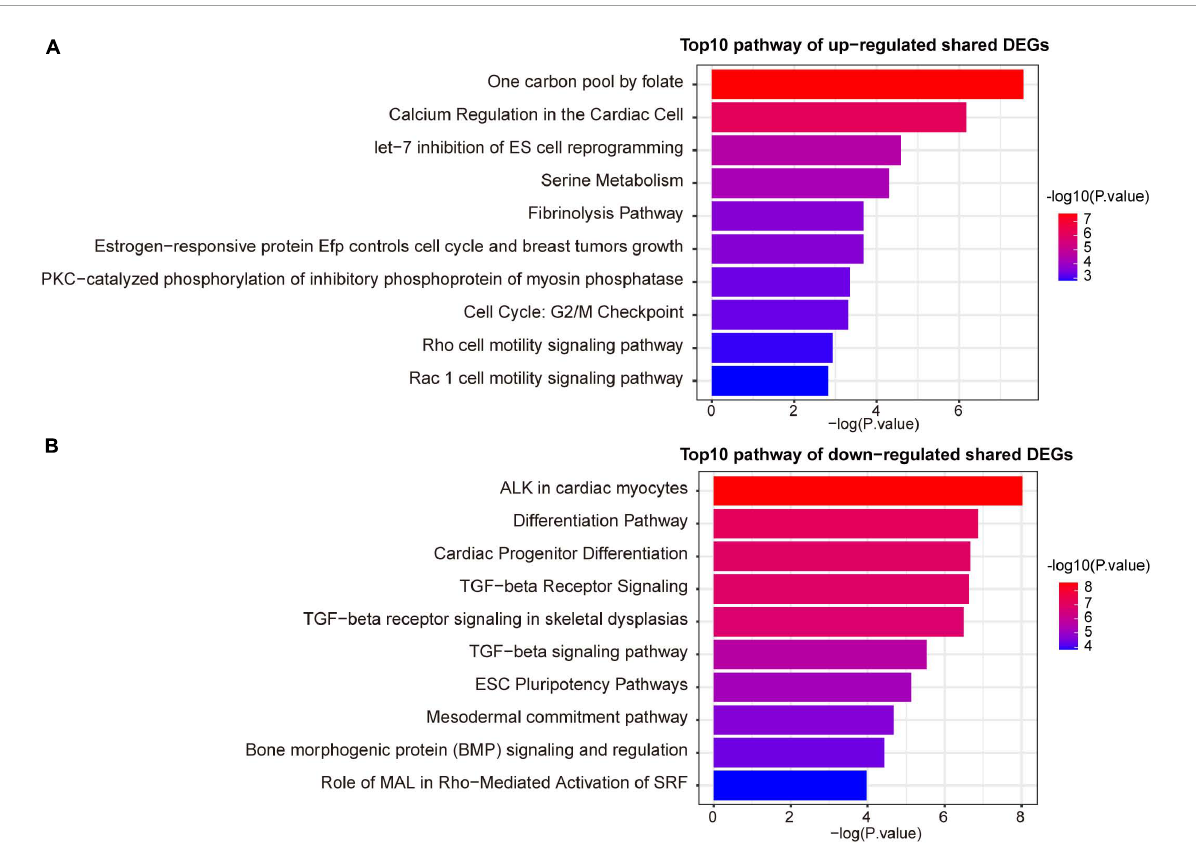
FIGURE3 The top 10 signaling pathways of up-regulated (A) and down-regulated (B) shared